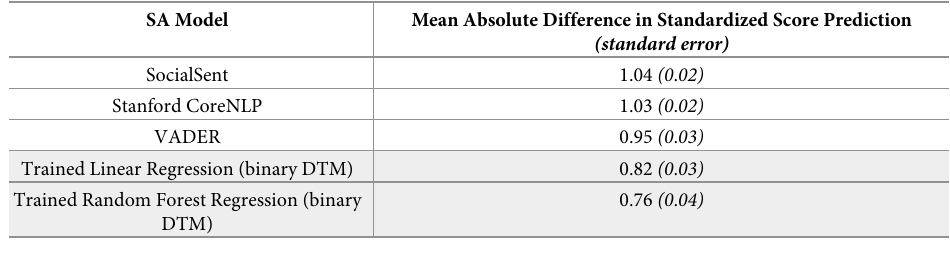
Table 1. Comparison of Model Fit Between Existing SA Packages and Our